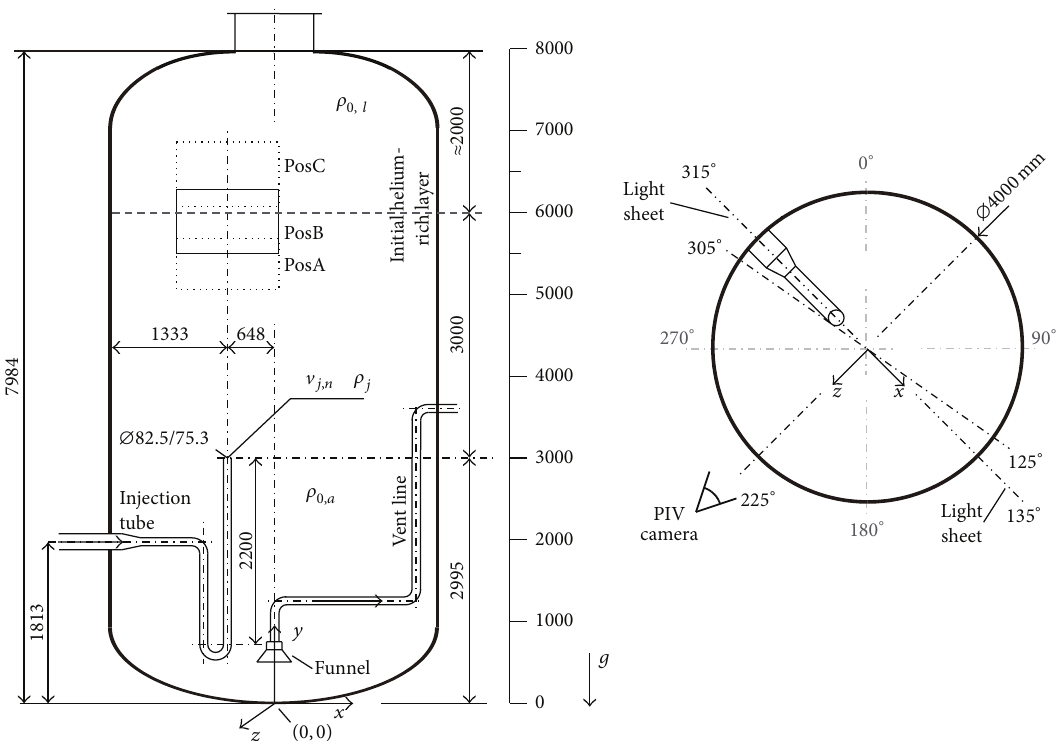
Figure 1: Schematic side and top view of the experimental facility with the initial helium-rich layer located in the vessel dome. The main dimensions are given in mm.